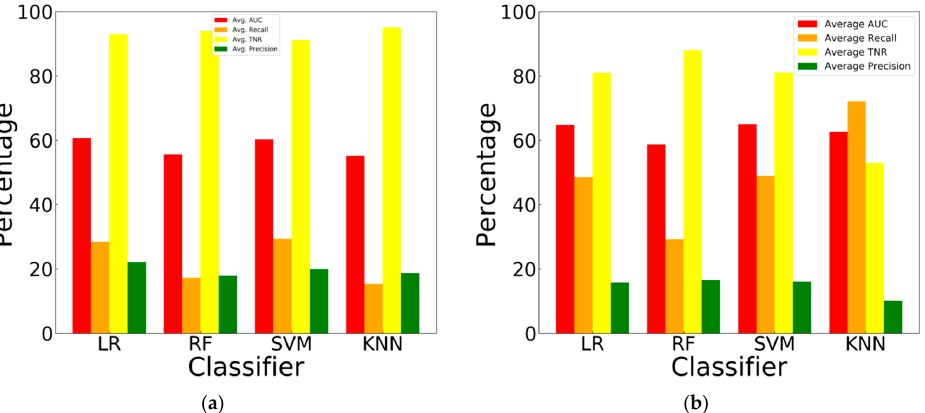
Figure 7. Averaged results of each classifier on: ( a ) Imbalanced data; ( b ) Balanced data.